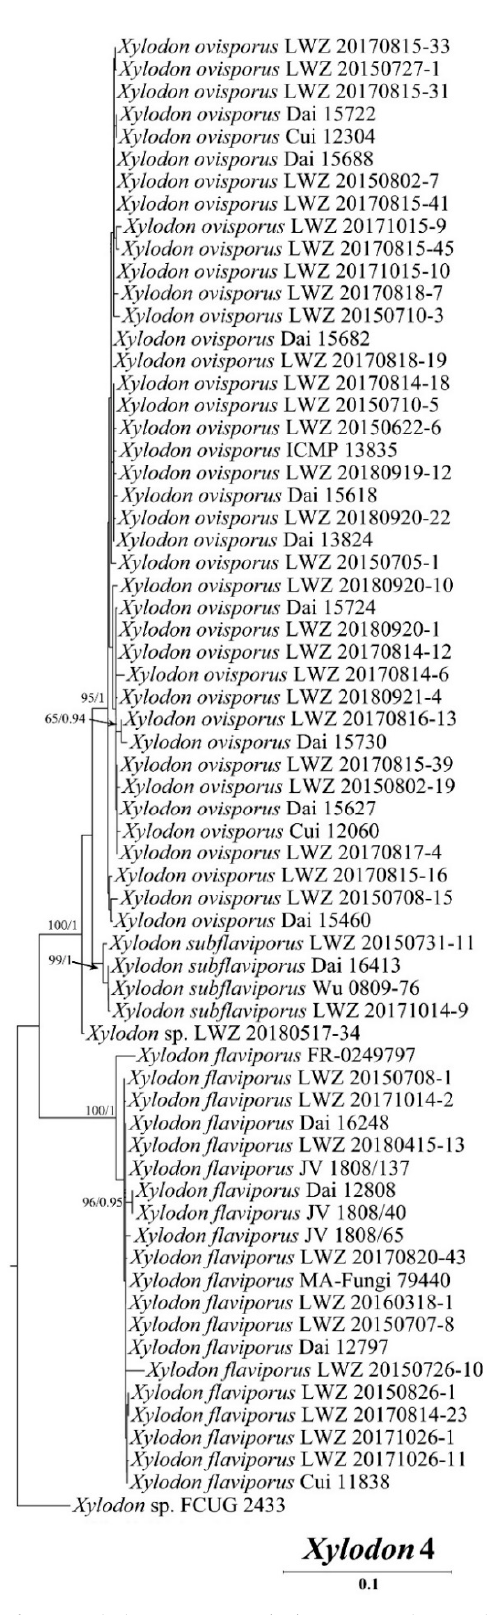
Figure 2. Phylogenetic relationships of species belonging to Hyphodontia sensu lato within Hymenochaetales inferred from the combined dataset of ITS, nLSU and mt-SSU regions. The topology generated by the maximum likelihood algorithm is presented along with the bootstrap values and the Bayesian posterior probabilities above 50% and 0.8, respectively, at the nodes.